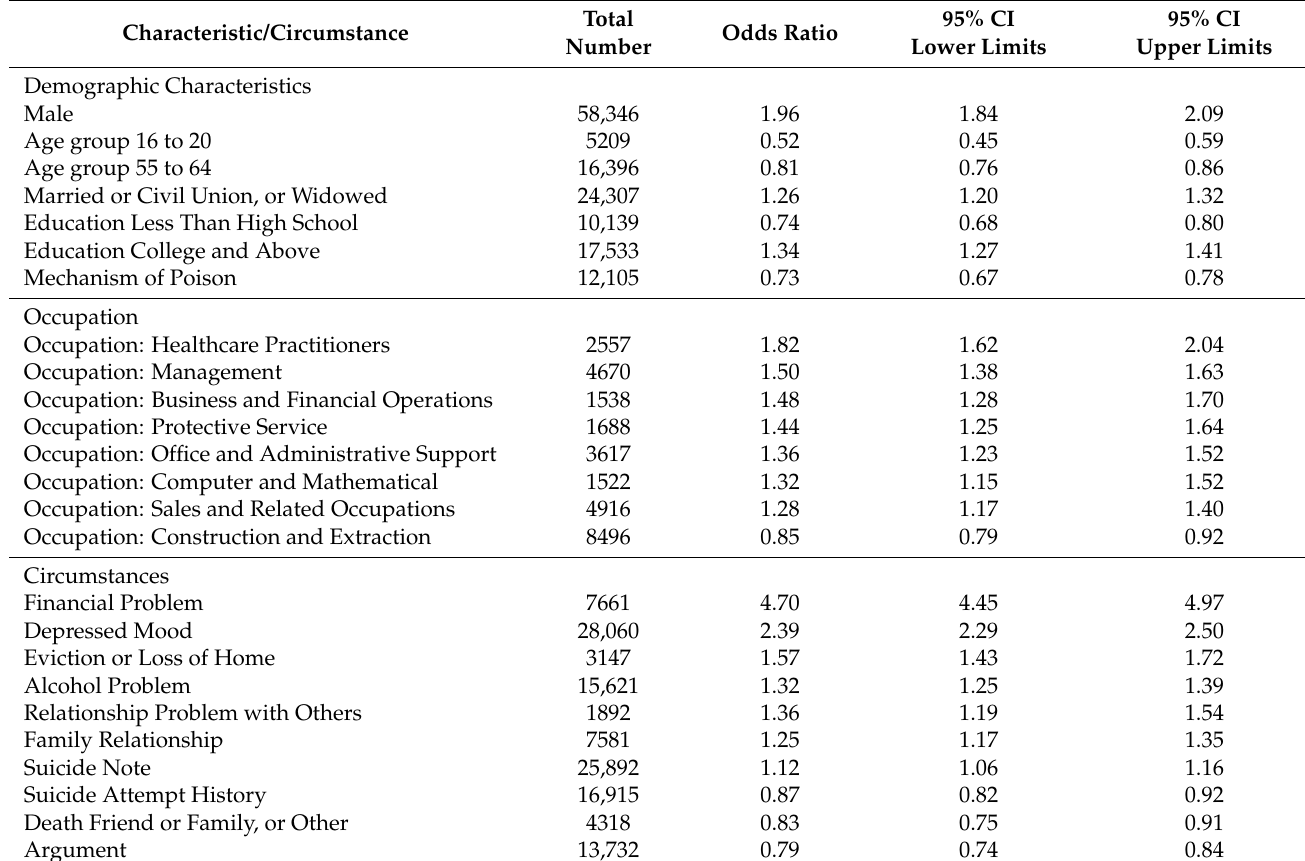
Table 4. Characteristics and circumstances predicting work-related suicides (minor and major factors combined), National Violent Death Reporting System, 2013 through 2017